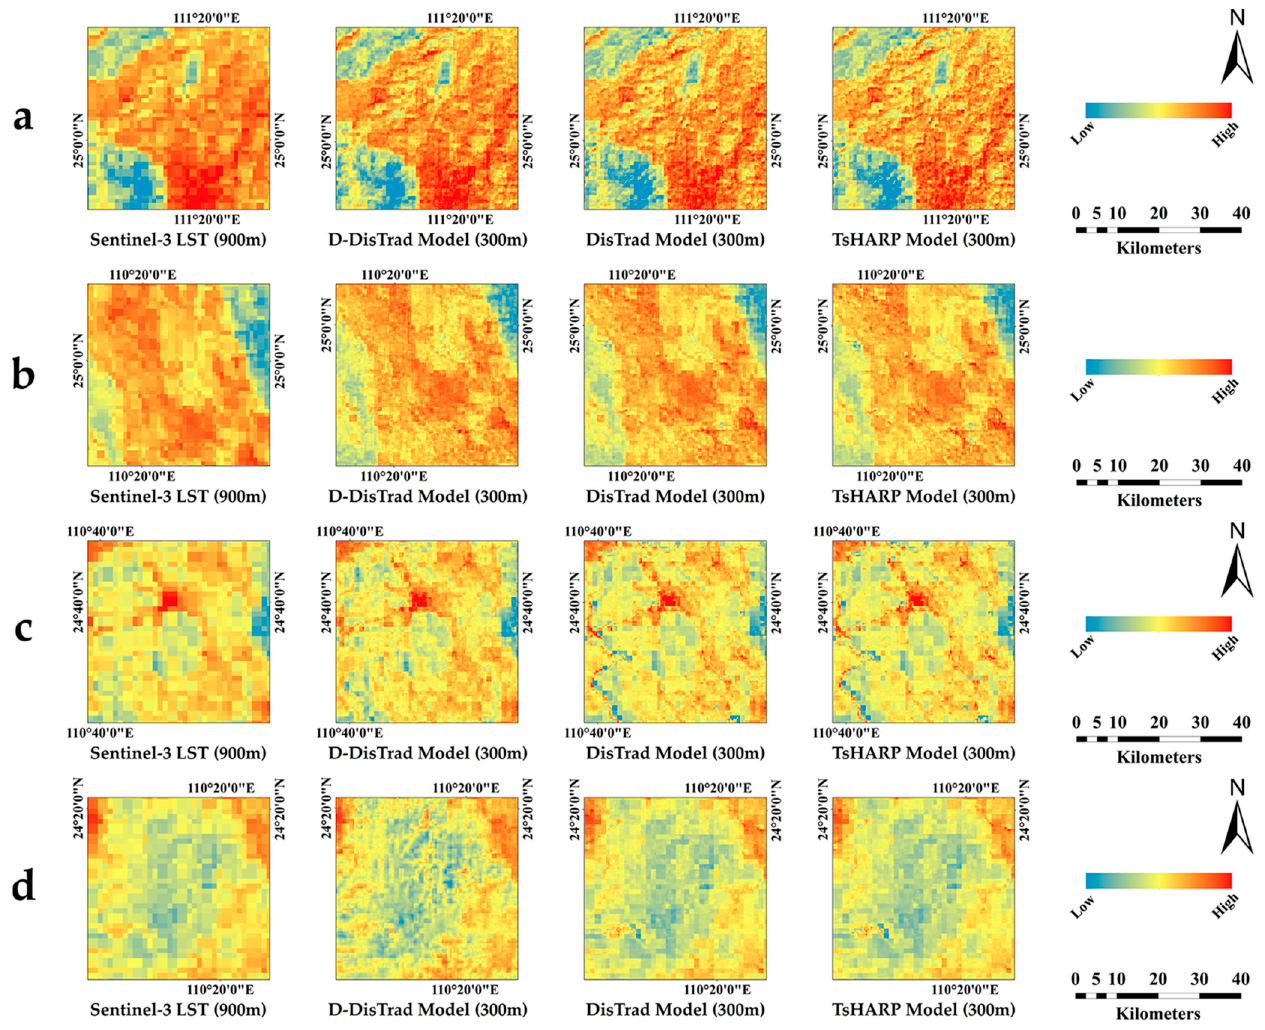
Figure 8. Each line goes from left to right, showing SLSTR LST, D-DisTrad LST, DisTrad LST, and TsHARP LST data. Areas with noticeable changes in site 2 across 4 seasons: ( a ) winter; ( b ) spring; ( c ) summer; ( d ) fall. Table 4. Statistics for the three downscaling results (300 m) in comparison with Landsat 8 LST data for 4